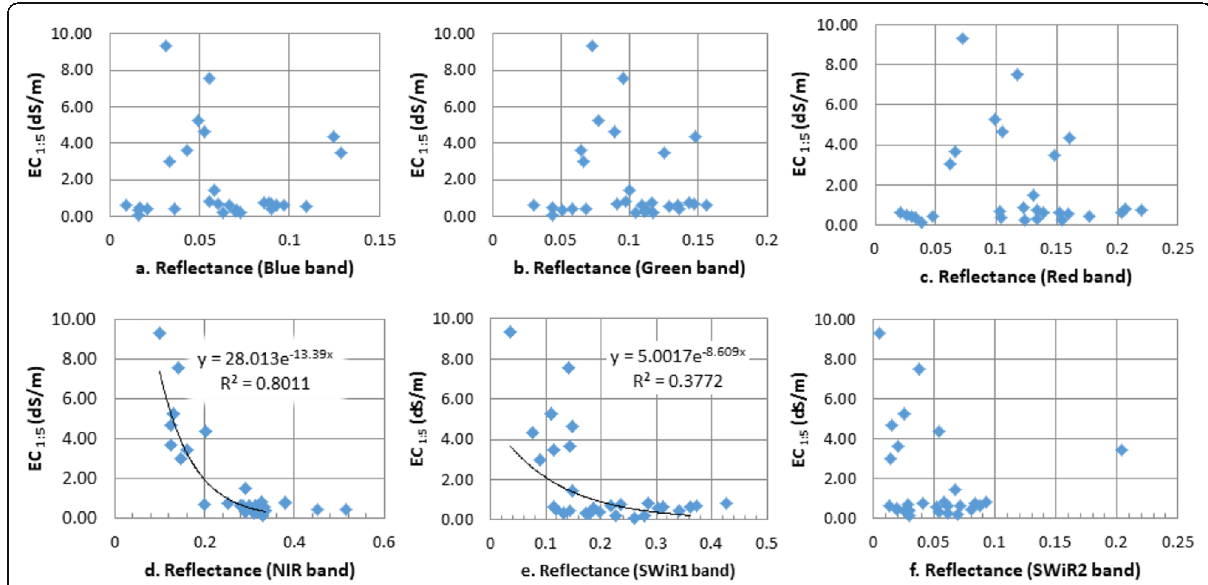
Fig. 6 Correlations between electrical conductivity (EC 1:5 ) and spectral reflectance at different bands of Landsat 8 OLI image acquired on 14/02/2017: between EC and a blue band, b green band, c red band, d NIR band, e shortwave infrared 1 (SWIR1) band, and f shortwave infrared 2 (SWIR2)